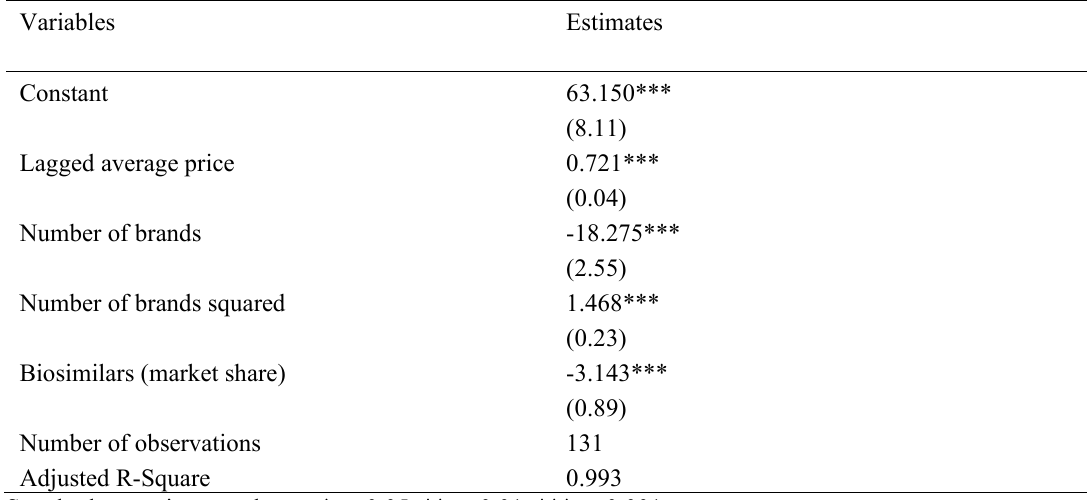
Table 3. Estimates - model